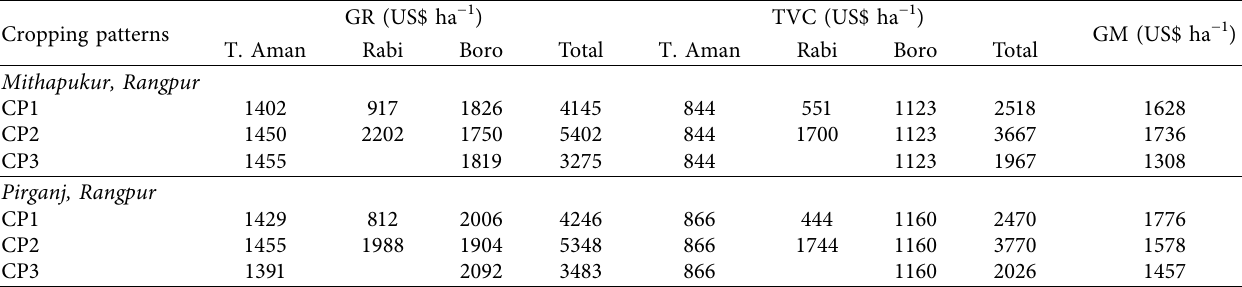
Table 6: Gross margin (GR), total variable cost (TVC), and gross margin (GM) of different cropping patterns (CP1: T. Aman-Mustard- Boro, CP2: T. Aman-Potato-Boro, CP3: T. Aman-Fallow-Boro) at Rangpur during 2019–2020. Cropping